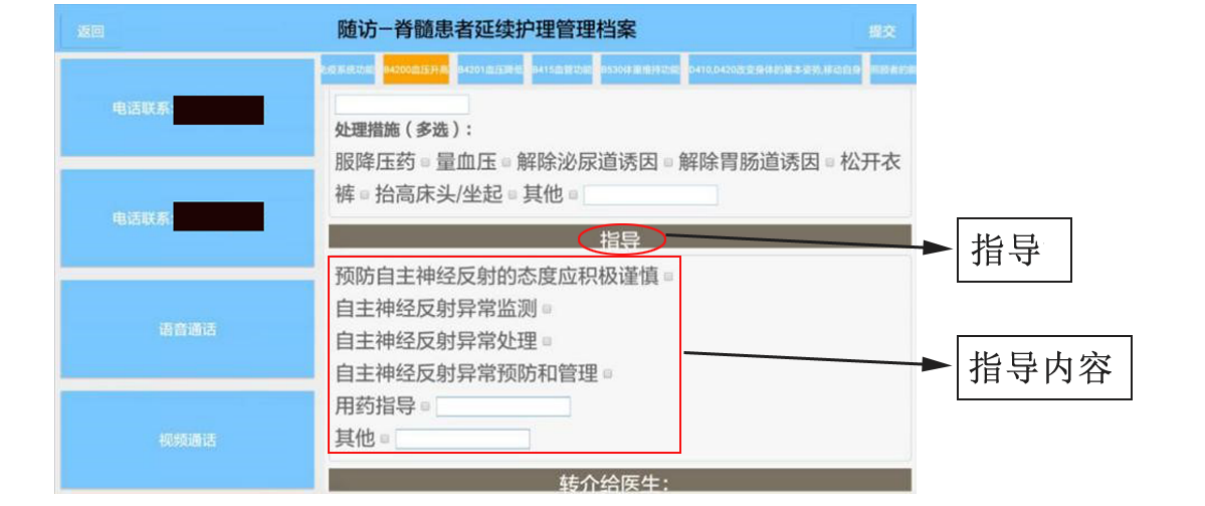
The referral function is a closed loop processing mode. When the follow-up nurses encountered problems that did not belong to the SCI nursing specialty, such as drug use and home modifications, referral messages were sent by the nurses to the